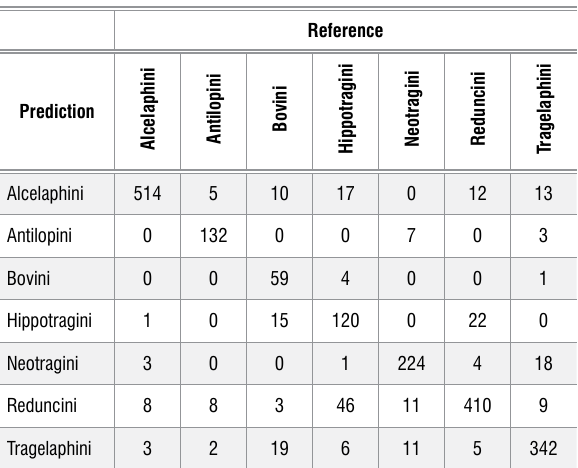
Table 2: Confusion matrix of the unworn teeth. These teeth had a correct classification accuracy rate of 0.8709. Reference